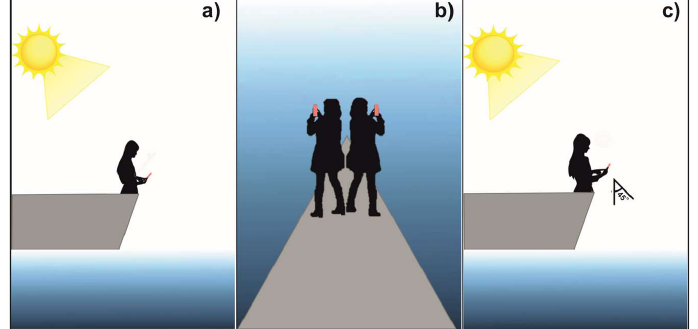
Figure 2. Scheme depicting the steps to follow to capture an image of the sea surface. With the sun on the back ( a ), rotate 45° to the left or right of the initial position to achieve 135° in the azimuth between the position of the sun and his/her visual field ( b ), place the camera lens at 45° relative to the sea surface and capture the image ( c ). At least six digital images were captured at each station. We selected images captured at exactly 45° from the sea surface and with no foam within the central zone. To obtain the digital colors (R, G, B), the images were processed in Corel Photo Paint X8. According to Leeuw and Boss [51], for each image, four 1 cm × 1 cm quadrants were selected; in each quadrant, a color histogram was obtained, from which the digital values (R, G, B) were extracted Figure 3. To reduce the natural variability of water color, the digital values of each station were taken as the mean of the values obtained from all quadrants in all the images selected for each station.